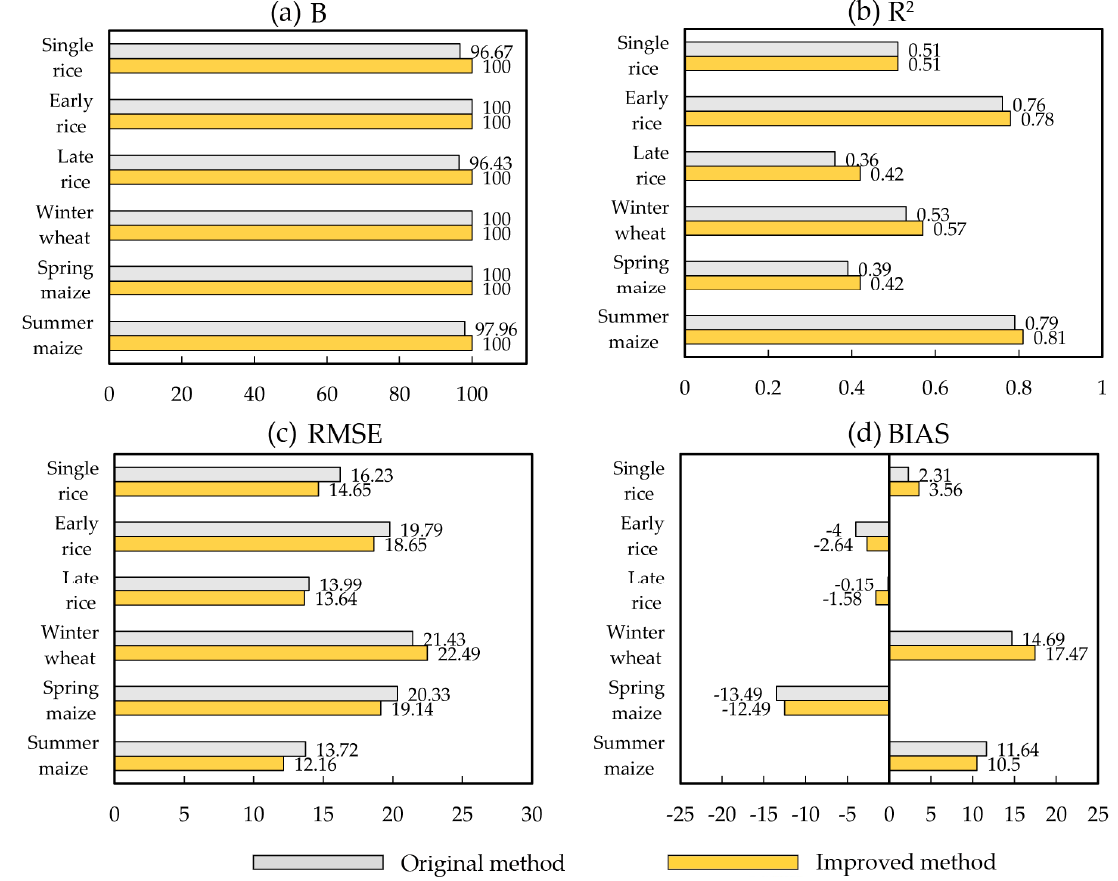
Figure 3. Comparison of the start of the season (SOS) retrieval results before (gray bars) and after algorithm improvement (orange bars), and both are based on the 20% amplitude threshold. ( a ) B, ( b ) Coefficient of determination (R 2 ), ( c ) Root Mean Square Error (RMSE), ( d ) BIAS.